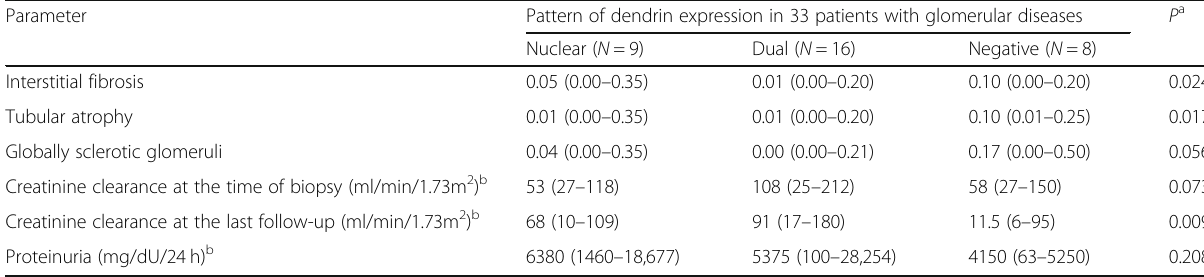
Table 4 Dendrin expression pattern in relation to pathohistological and clinical parameters Parameter Pattern of dendrin expression in 33 patients with glomerular diseases